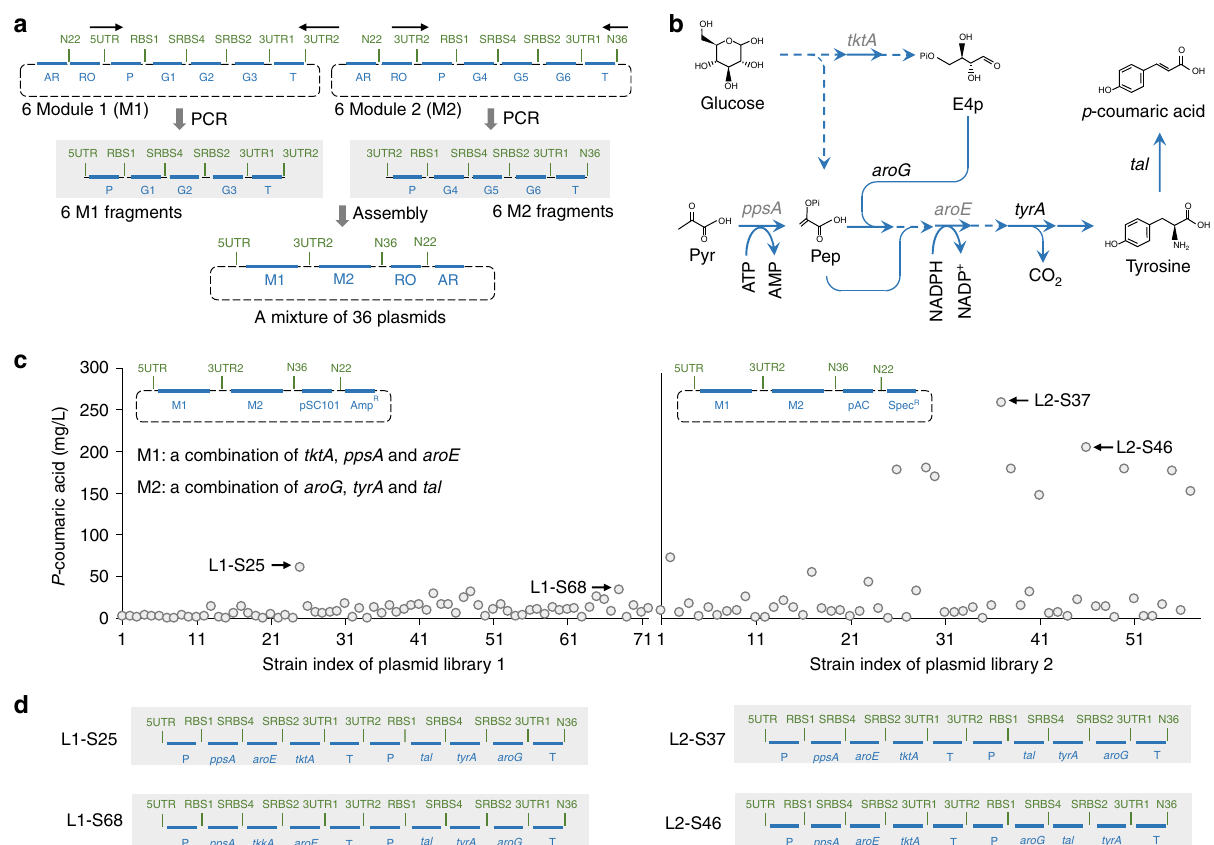
Fig. 7 Constructing plasmid library using standard parts for combinatorial optimization of p -coumaric acid production in E. coli . a Construction of two combinatorial plasmid libraries to enhance p -coumaric acid production of E. coli . Six genes involved in shikimate production ( ppsA , tktA , and aroE ) and p - coumaric acid production ( aroG , tyrA , and tal ) were divided into two modules. Each module has six variants resulting from shuf fl ing three genes. To prepare one library, six Module 1 (M1) plasmids and six Module 2 (M2) plasmids were made. Both M1 and M2 plasmids used the same promoter (pthrC3) and terminator (T7 terminator). Then, six M1 fragments and six M2 fragments were ampli fi ed from M1 and M2 plasmids by using two sets of Aoligos as indicated in black arrows (PCR results are presented in Supplementary Fig. 9a). The ampli fi ed M1 and M2 fragments were mixed equimolarly, and assembled with a plasmid backbone (pSC101 with Spec R or pAC with Spec R ). In library 1, pSC101 was used. In library 2, pAC was used. More details of